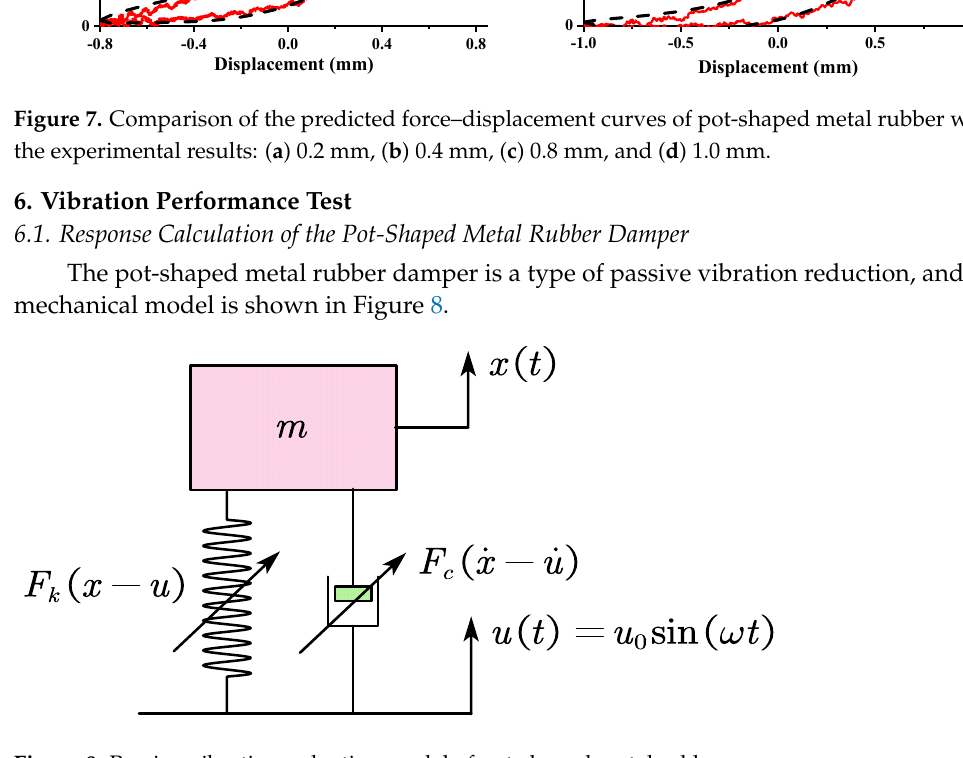
Figure 8. Passive vibration reduction model of pot-shaped metal rubber.